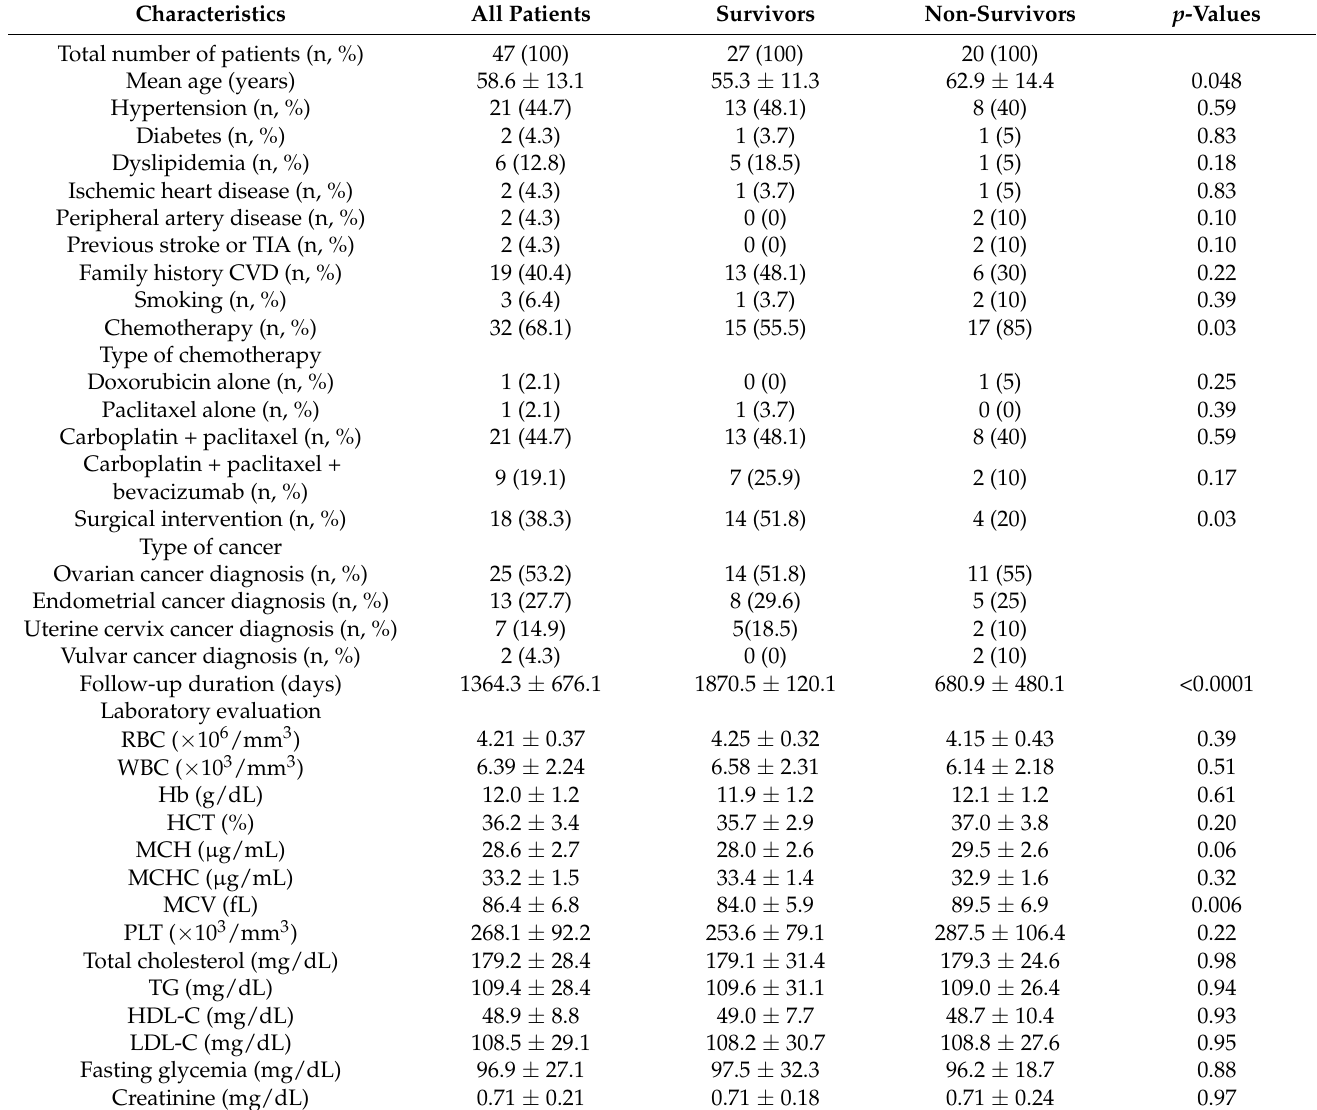
Table 1. Baseline characteristics of the overall study population of surviving and non-surviving patients. Characteristics All Patients Survivors